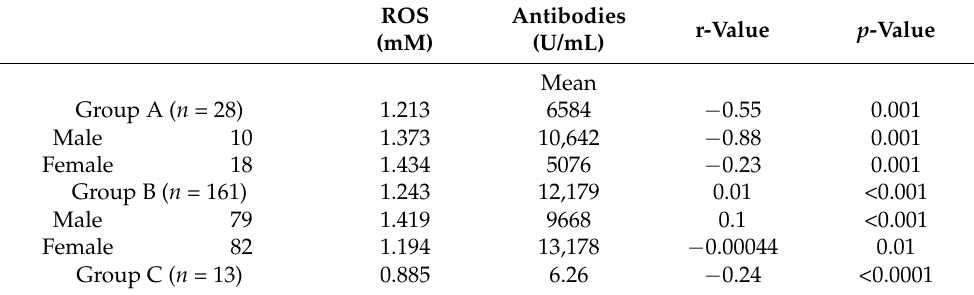
Table 3. Reactive oxygen species (ROS) levels (a.u) and antibodies (U/mL) of selected participants ( n = 202). Group B, participants 45 days after infection with COVID-19; Group A, vaccinated par- ticipants 45 days after receiving the vaccine dose; Group C, non-infected, non-vaccinated controls. Significant differences are represented as p < 0.001. ROS Antibodies (mM)